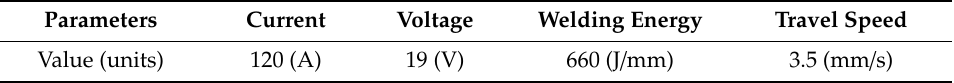
Table 2. Deposition parameters for the steady stage part of the